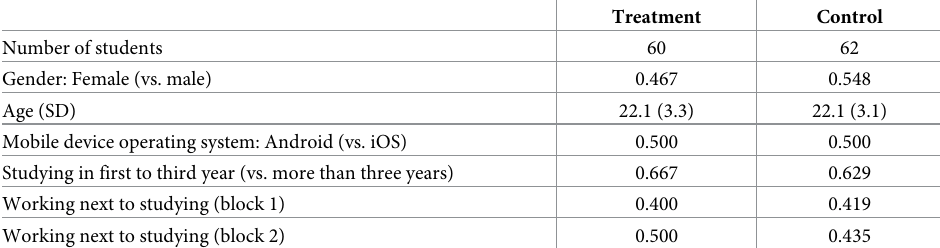
Table 3. Descriptive statistics of the